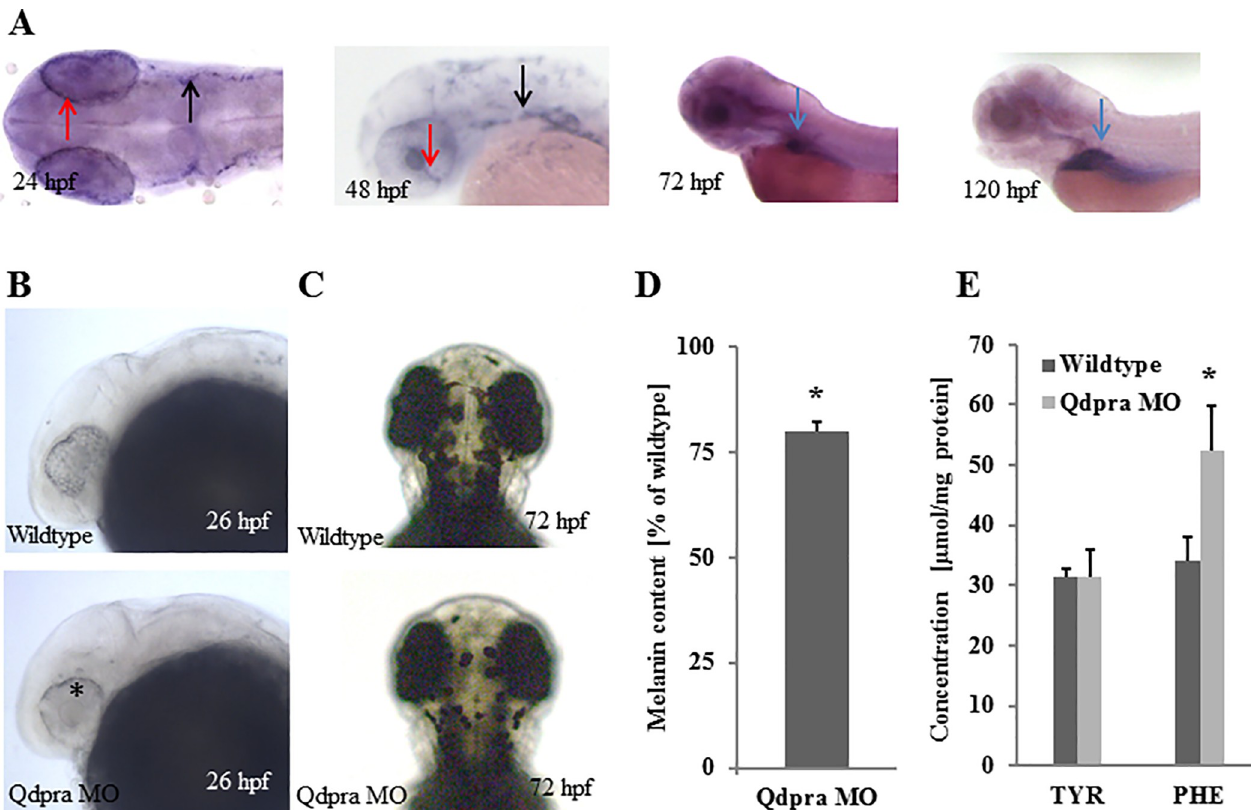
Fig 1. Characterization of Qdpra. (A) WISH of qdpra at 24 hpf (dorsal view, anterior to the left) shows staining in retinal pigment epithelium (red arrow) and neural crest cells/melanophore precursor (black arrow). At 48 hpf qdpra transcripts are found in the retinal pigment epithelium, choroid fissure (red arrow) and neural crest cells (black arrow). At 72 hpf and more pronounced at 120 hpf (lateral views, anterior to the left), staining is present in the liver (blue arrow). (B) Lateral views with anterior to the left and (C) dorsal views with anterior to the top of embryos at stages indicated. Knockdown of qdpra results in reduced pigments in the eye (asterisk) at 26 hpf (B) and overall diminished pigmentation at 72 hpf (C). (D) At 72 hpf melanin content is reduced by 20% (of wildtype) in Qdpra hypomorphic zebrafish. (E) Amino acid analysis shows hyperphenylalaninemia and normal tyrosine upon qdpra knockdown.